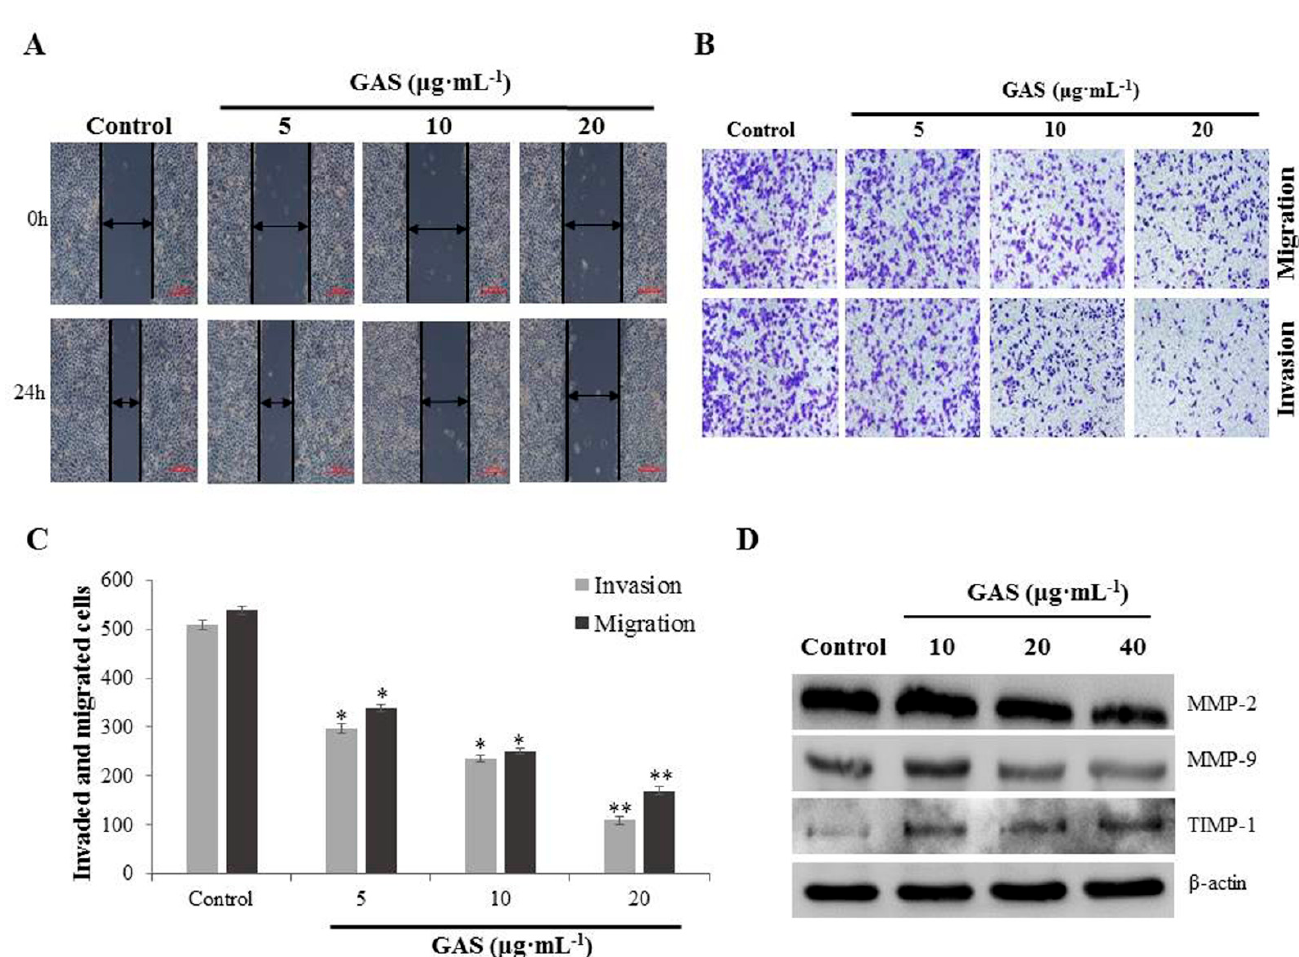
Figure 3. GAS suppressed invasion and migration of CNE-2Z cells. ( A ) Migration was analyzed by a wound-healing assay after being treated with various concentrations (5, 10, and 20 µ g · mL − 1 ) of GAS. ( B ) Cell invasion and migration were determined using a transwell assay after treatment with GAS (5, 10, and 20 µ g · mL − 1 ). ( C ) Quantification of invasion and migration of CNE-2Z cells suppressed by GAS. ( D ) Western blotting analyses of MMP-2, MMP-9, and TIMP-1 levels in CNE-2Z cells. β -Actin was used as an internal control. * p < 0.05 and ** p < 0.01 compared to the control.